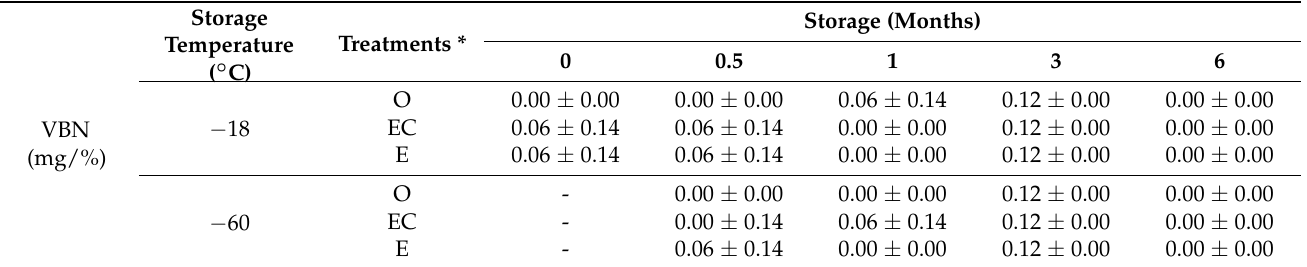
Table 7. VBN (mg/%) of meat analogs with different fat replacers (O, EC, and E) during the freezing storage ( − 18 ◦ C, − 60 ◦ C) for six